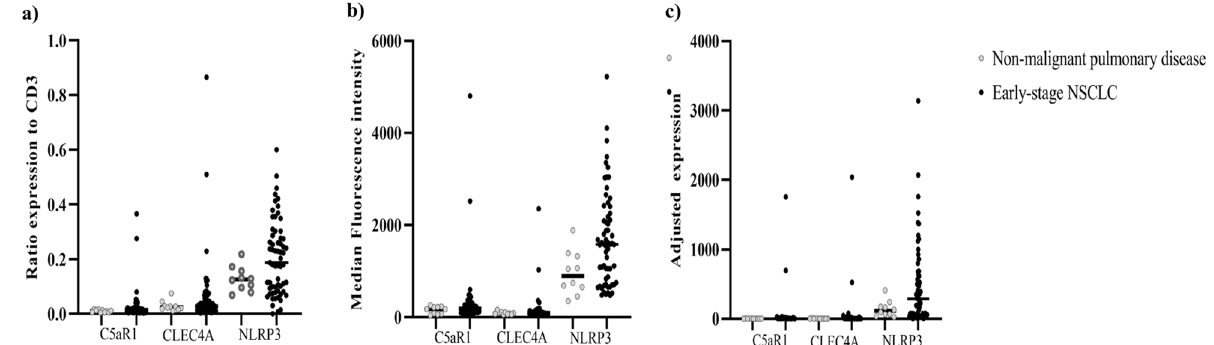
Figure 2. Represented the ratios ( a ), median fluorescence intensity ( b ) and adjusted expression ( c ) of C5AR1, CLEC4A and NLRP3 proteins on CD3 + lymphocytes between non-malignant pulmonary diseases (n = 10) and early-stage NSCLC patients (n = 63). Median fluorescence intensity of CD3 + NLRP3 + in early-stage NSCLC patients was 1585 [range 478–5224] which was higher than non-malignant pulmonary diseases, 899 [range 354– 1888, p = 0.01]. The limited number of patients with non-malignant pulmonary disease in our study impacted the ability to show if PBMCs protein expression as a biomarker could discriminate between these